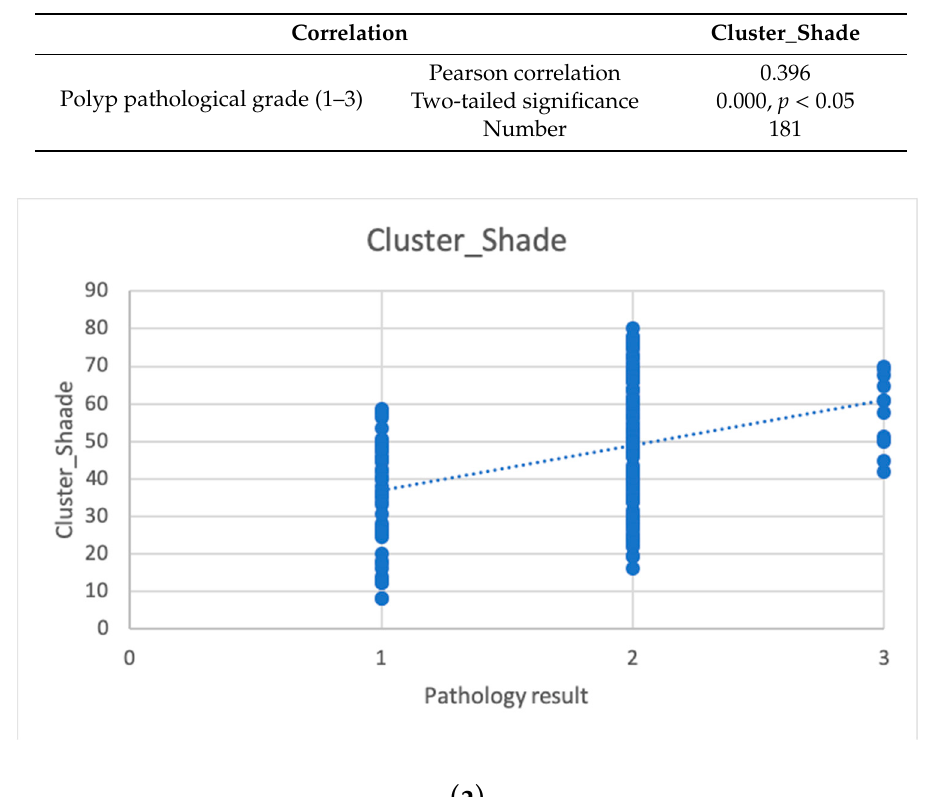
Table 4. Association of cluster_shade with pathological grade.